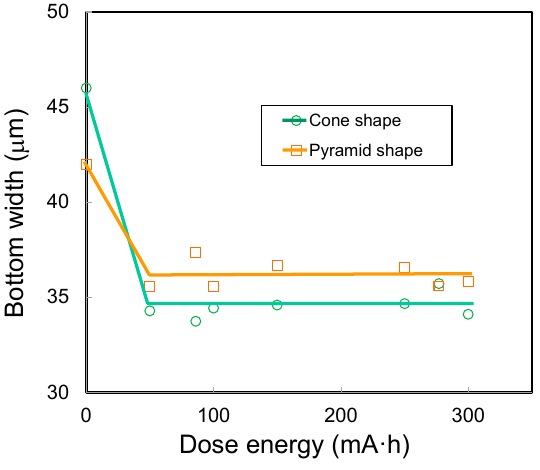
Figure 8. Bottom width of the PMMA structures fabricated by X-rays which penetrated through the cone and pyramid shaped structures of the Si absorbers depended on the dose